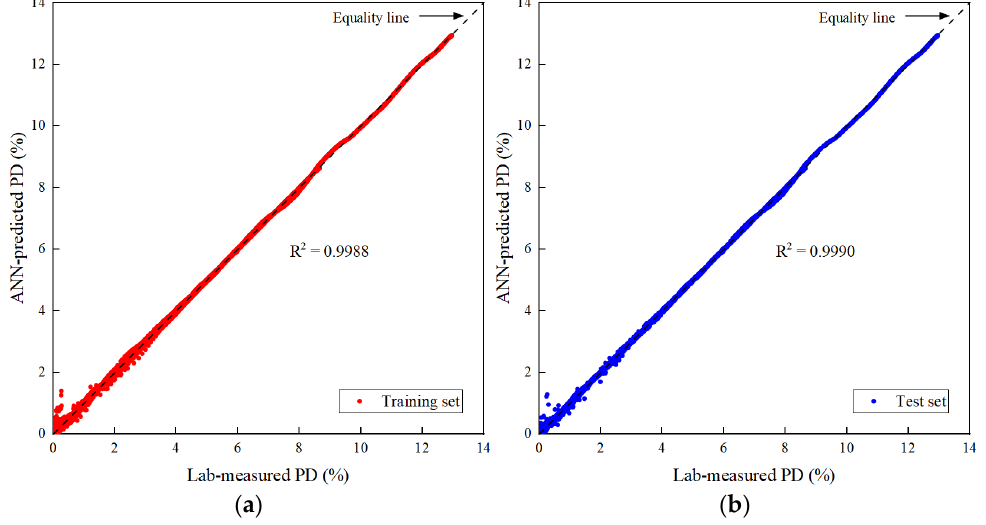
Figure 15. The goodness-of-fit results: ( a ) Training set; and ( b ) Testing set.